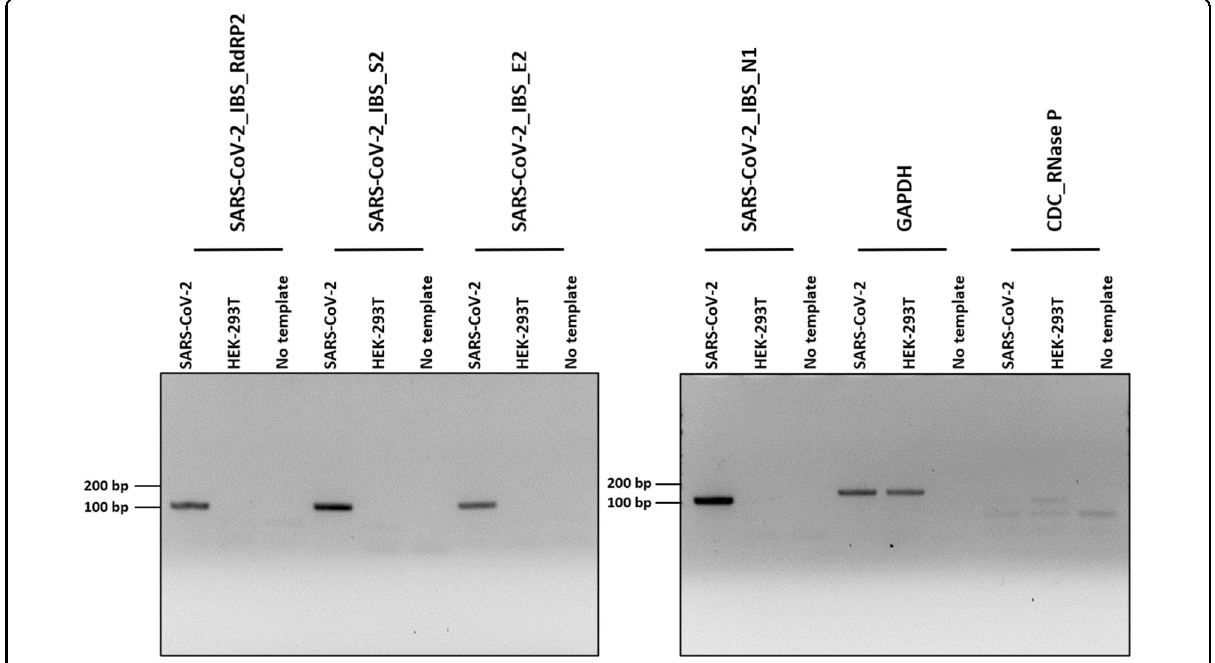
Fig. 3 Development of a traditional PCR protocol for SARS-CoV-2 detection. Gel electrophoresis results from PCR (35 cycles) using the primer sets SARS-CoV-2_IBS_E2, SARS-CoV-2_IBS_RdRP2, SARS-CoV-2_IBS_S2, and SARS-CoV-2_IBS_N1. GAPDH primers were used as the IPC primer set. The predicted size of the amplicons was approximately 100 bp. Five nanograms of SARS-Cov-2 cDNA (4.5 × 10 8 copies/reaction) or HEK-293T cDNA (1.5 × 10 3 copies/reaction) was used for each reaction. The no-template condition contained no